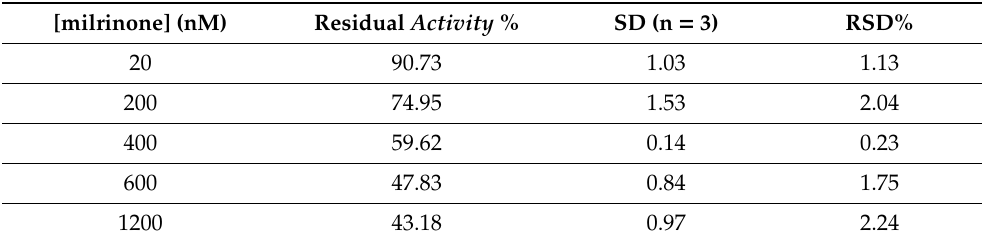
Table 3. Residual enzymatic activity % calculated by adding different solutions at increasing concentrations of milrinone, as inhibitor. SD: Standard Deviation; RSD: Relative Standard Deviation.